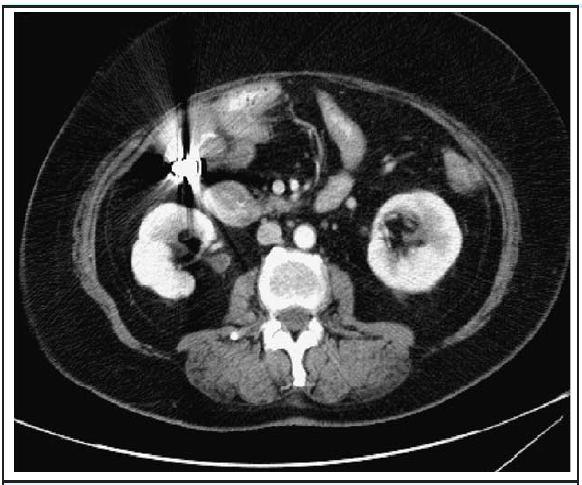
Figure 9. Axial section at distal ileum demonstrates the retained foreign body just proximal to the narrowed ileocolic anastomosis site. Even though capsule endoscopy did not help us to diagnose a definite lesion, as we did not take clear images of the site of capsule retention, palpation of the capsule by the surgeons during operation,